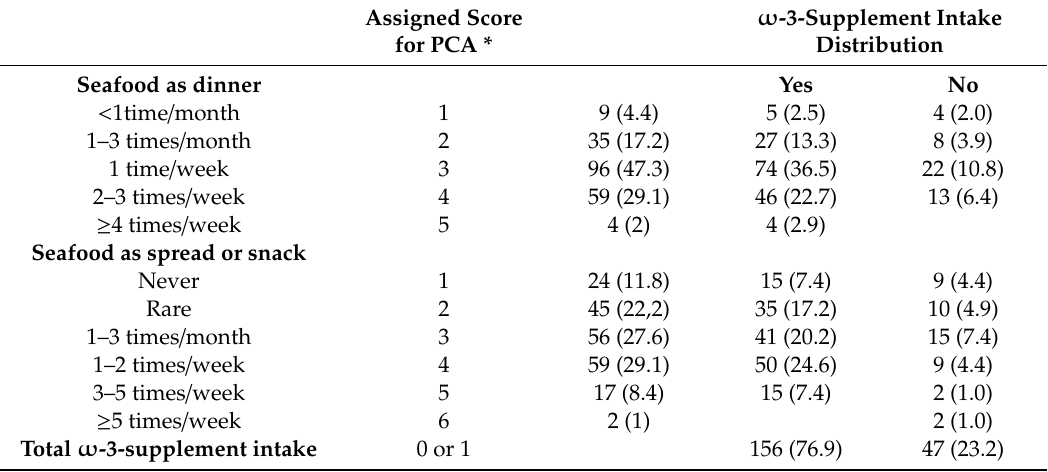
Table 2. Intake frequencies for seafood as dinner, seafood as spread / snack and omega-3 ( ω -3) supplements among Norwegian pregnant women ( n = 203). Unbracketed and bracketed figures represent the actual number of participants and the corresponding percentage (%). ω -3-Supplement Intake Assigned Score for PCA * Distribution Seafood as